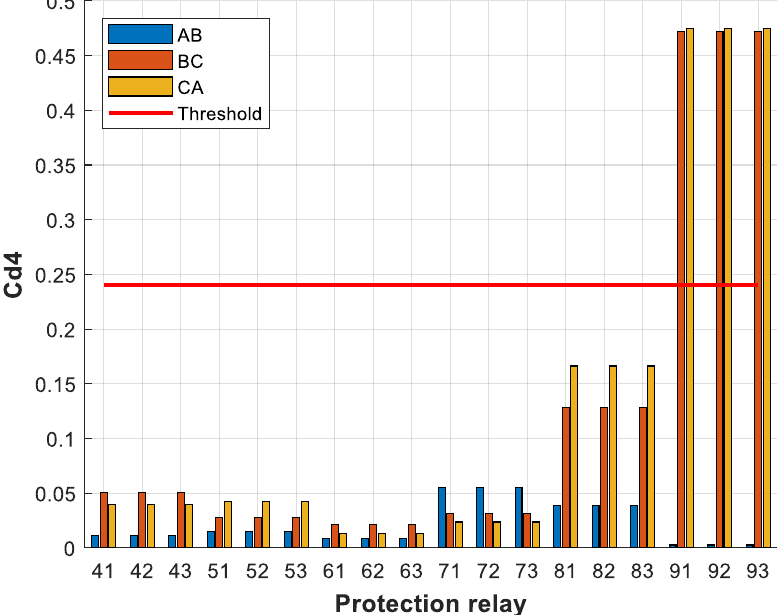
Figure 11. Differences in the voltage Cd4-dB3 on the transmission line from bus 8 to bus 9.